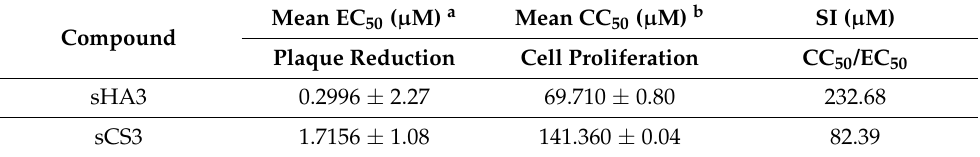
Table 3. Antiviral activities of high sulfated glycosaminoglycans against